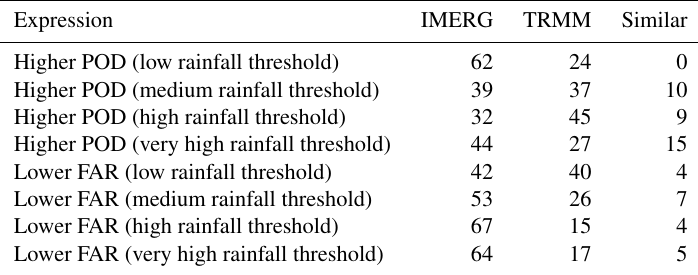
Figure 7. Spatial representation of probability of detection (POD) for (a–c) low (25 percentile), (d–f) medium (50 percentile), (g–i) high (75 percentile) and (j–l) very high (95 percentile) rainfall threshold for TRMM 1998–2013, TRMM 2014 and IMERG 2014 rainfall estimates over 86 delineated river basins across India. Table 6. Comparison of IMERG and TRMM based on the number of basins in which the satellite products show higher/lower POD/FAR based on the year 2014. The last column gives the number of basins in which IMERG/TRMM gives similar POD/FAR. The low, medium, high and very high thresholds are the 25, 50, 75 and 95th percentile,